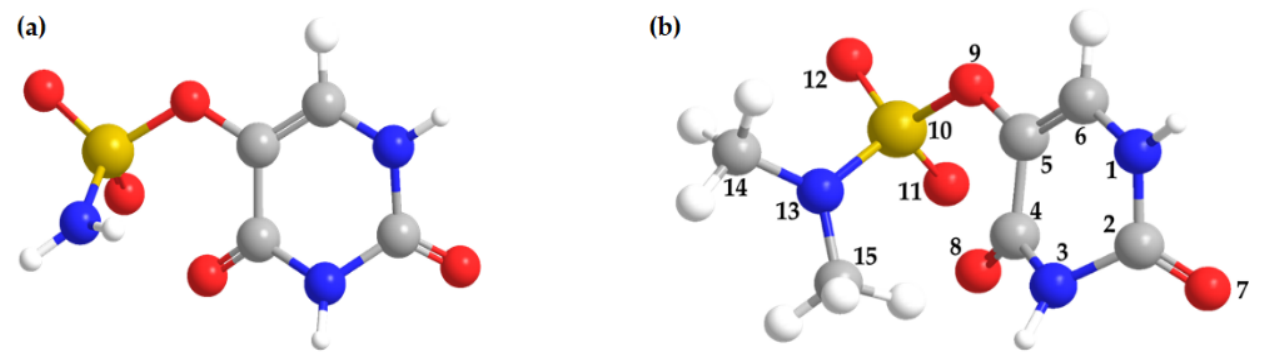
Figure 1. Molecular structure of ( a ) uracil-5-yl O -sulfamate (SU) and ( b ) uracil-5-yl O- ( N , N -dimethylsulfamate) (DMSU).